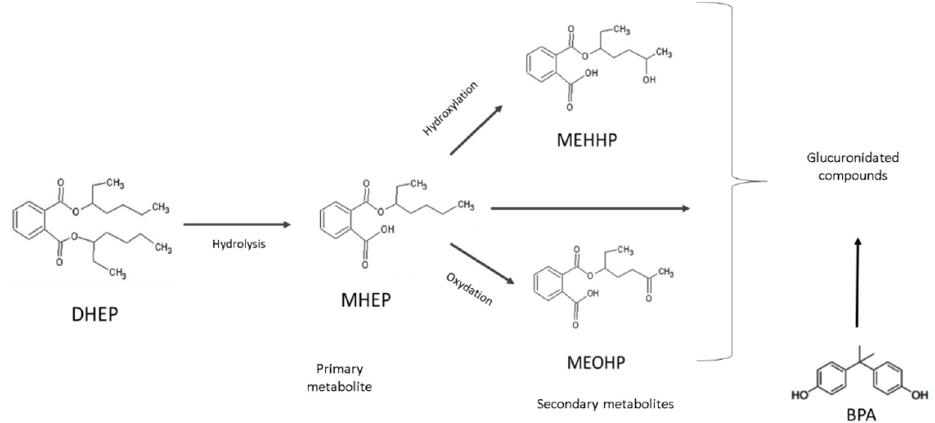
Figure 2. Metabolism of DEHP and BPA. DEHP is hydrolyzed in MEHP and is again hydrolyzed in MEHHP or is oxidated in MEOHP; the three metabolites are conjugated with glucuronic acid. BPA is directly conjugated with glucuronic acid.